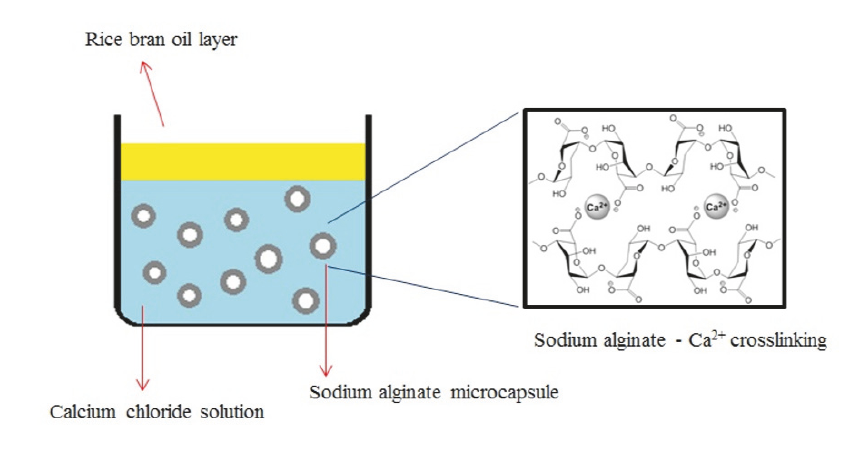
Figure 2: Sodium alginate crosslinking.